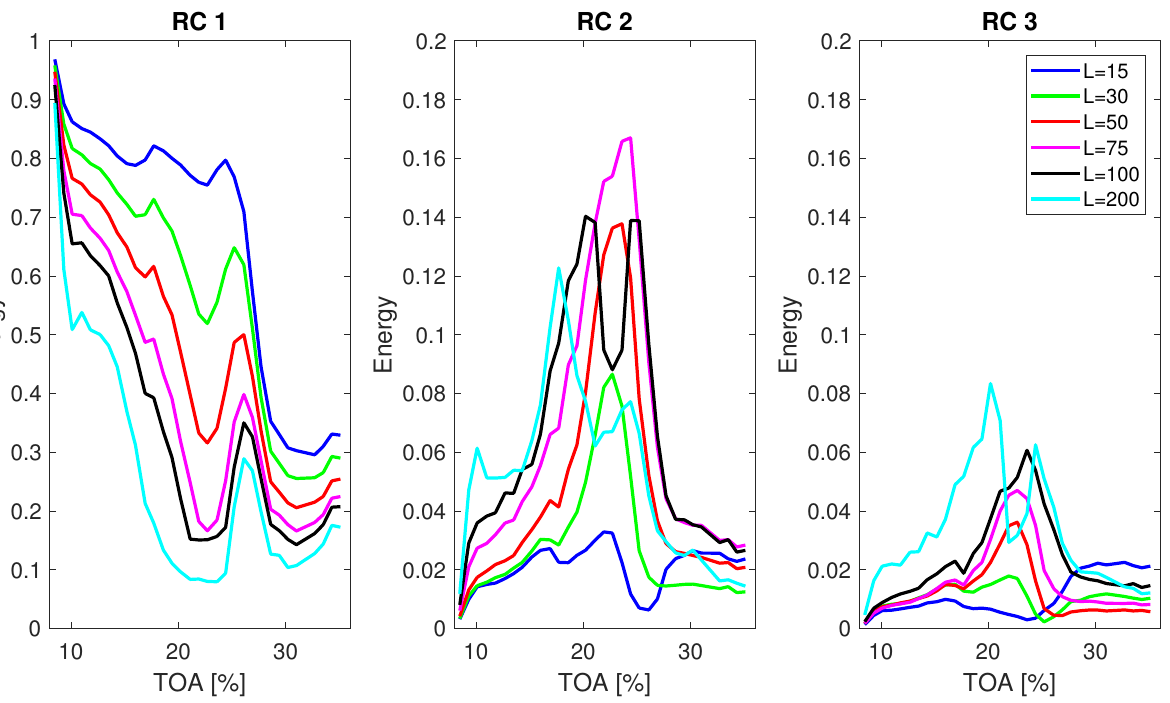
Figure 7. Mean energy E of RCs from 1 to 3 over different operating conditions for varying window length and signal length N =